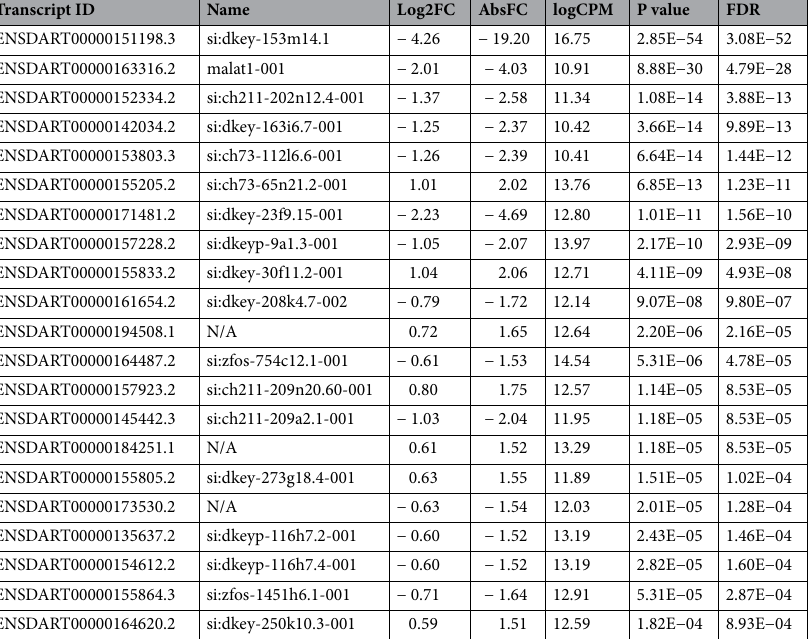
Table 6. Differentially expressed lincRNAs. Pairwise comparison between generations F 1 from exposed (8.7 mGy/h γ-radiation) (F 1 -γ) and control parents (F 1 -C). Transcript IDs and transcript names obtained from